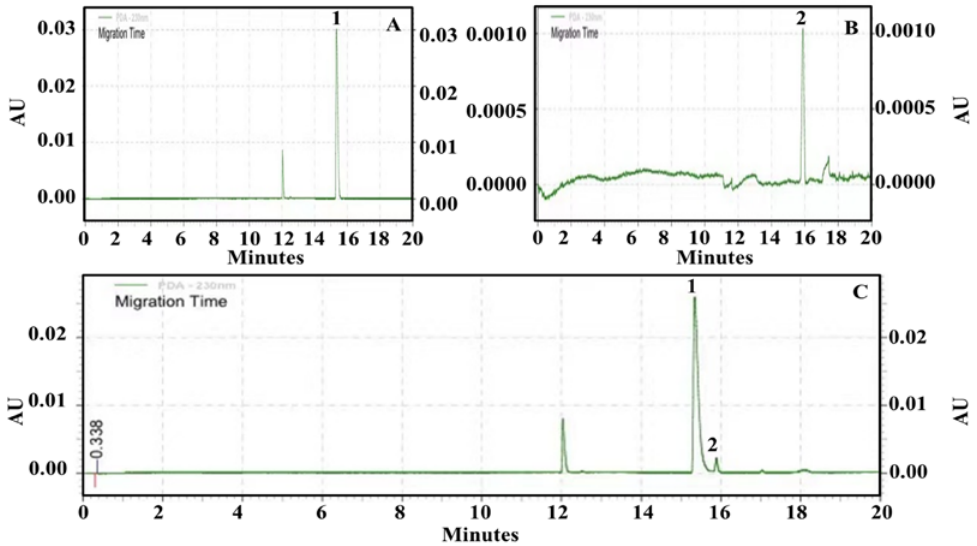
Figure 7. Capillary electrophoresis of acetylcholine (ACh) and choline (Ch) separation. ( A ) ACh standard (1) capillary electrophoresis diagram; ( B ) Capillary electrophoresis of Ch (2) standard; ( C ) Capillary electrophoresis after addition with AChE.